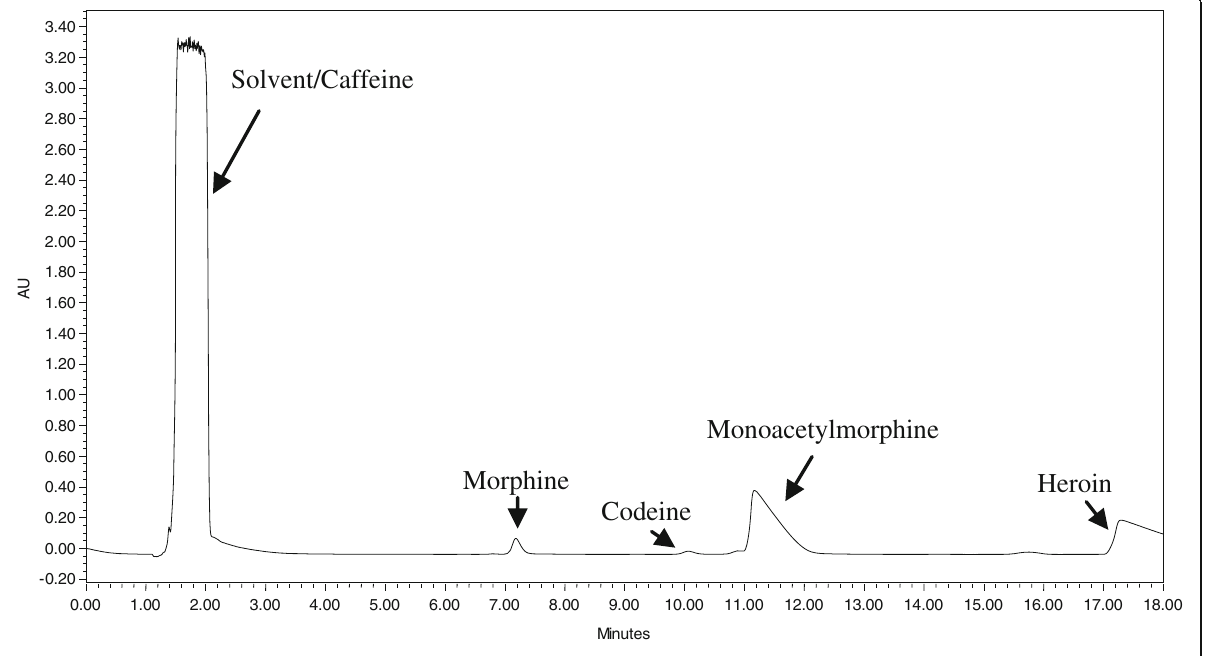
Fig. 1 Profile of eluting peaks from an illicit heroin